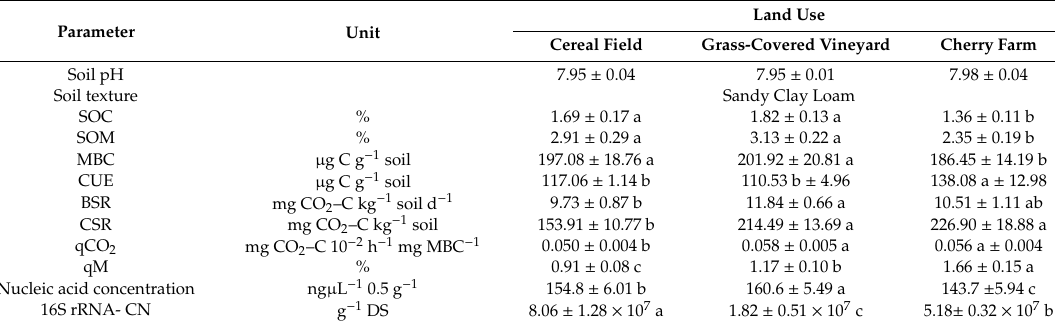
Table 3. Chemical and microbial parameters under di ff erent land use.